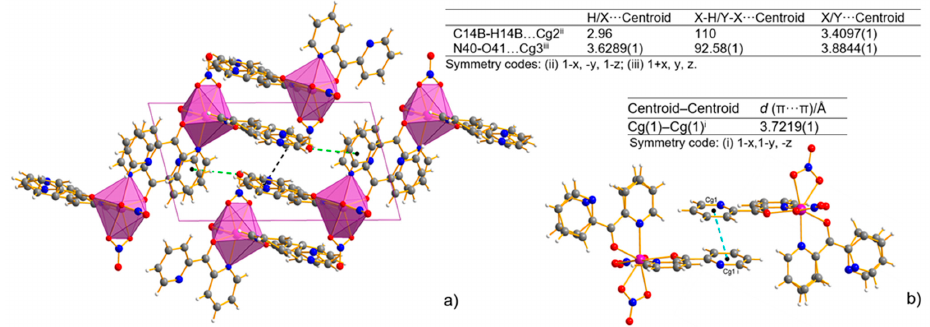
Figure 3. Packing view of the coordination polyhedral system forming a rhombic 3D network and the geometry of C–H · · · π (black line) and N–O · · · π (green line) interactions (X-H · · · π and Y-X · · · π interactions, view along [010] direction)—( a ), and π · · · π stacking interaction—( b ) for Mn-dipyCO- NO 3 . Cg(1) denotes the gravity ring center of N(31)-C(32)-C(33)-C(34)-C(35)-C(36); Cg(2) denotes the gravity ring center of C(12)-N(11B)-C(16B)-C(15)-C(14B)-C(13B); Cg(3) denotes the gravity